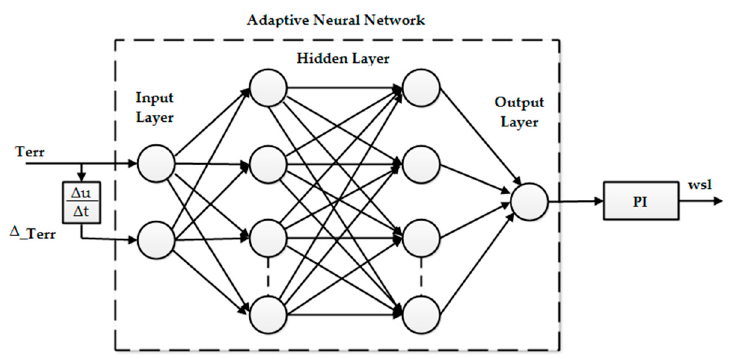
Figure 10. Structure of ANN Controller.